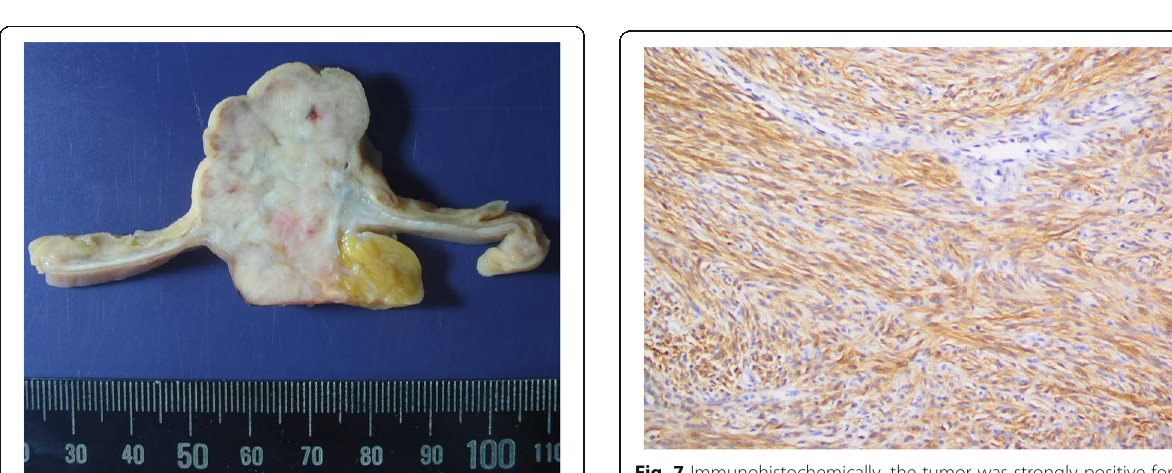
Fig. 7 Immunohistochemically, the tumor was strongly positive for c-kit (CD117), showing diffuse and cytoplasmic